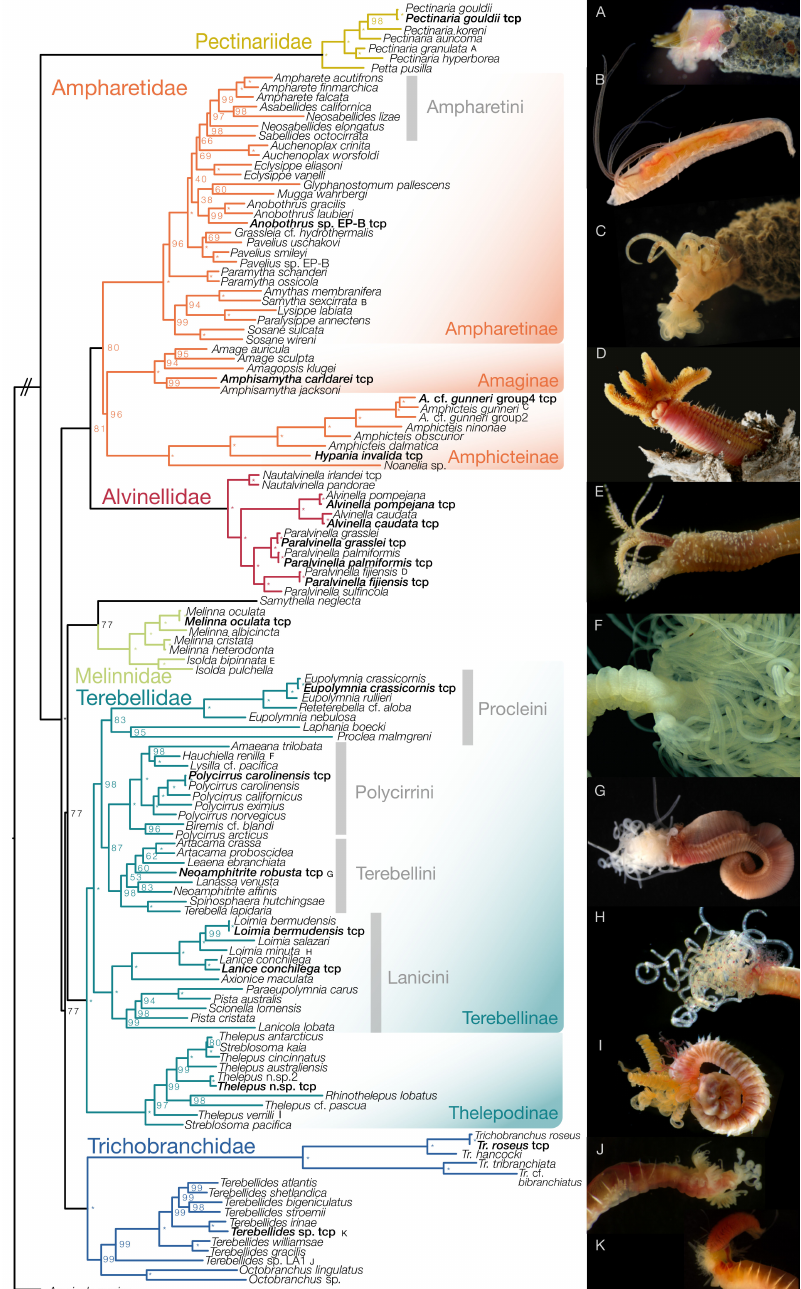
Figure 2. Relationships among Terebelliformia based on the multigene and morphological dataset (4249 characters) using maximum likelihood and constrained to the transcriptome backbone. Note that bootstrap support was free to vary despite the topological constraint. Asterisks indicate maximum bootstrap support. Terminals in bold are shared with the transcriptome phylogeny. The animals shown on the right are labeled in the phylogeny with letters ( A – K ). ( A ) Pectinaria granulata SIO-BIC A9441; ( B ) Samytha sexcirrata SIO-BIC A1110; ( C ) Amphicteis cf. gunneri group2 SIO-BIC A1107; ( D ) Paralvinella fijiensis SIO-BIC A8627 (not the sequenced specimen); ( E ) Isolda bipinnata SIO-BIC A9437; (F) Hauchiella renilla SIO-BIC A1116; ( G ) Neoamphitrite robusta SIO-BIC A9453; (H) Loimia minuta SIO-BIC A9452; ( I ) Thelepus verrilli SIO-BIC A9462; ( J ) Terebellides sp. LA1 SIO-BIC A9464; ( K ) Terebellides sp. SIO-BIC